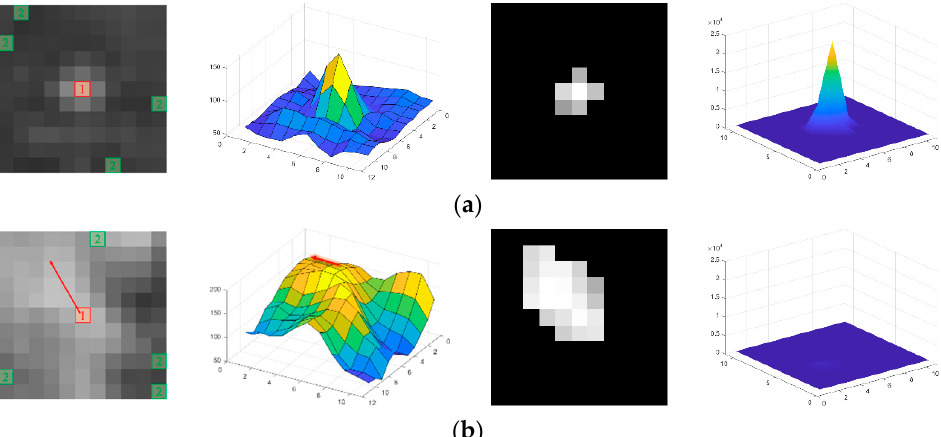
Figure 5. Target and background pixels in candidate targets are processed with LGD. ( a ) Local block containing target pixel; ( b ) Local block containing background pixel. The first column is the original images, where the green and red boxes are pixels labeled as 1 and 2, respectively. The second column is the 3D schematic of original images. The third column shows the pixels labeled as 1 with the RW algorithm. MGDE is shown in the fourth column.